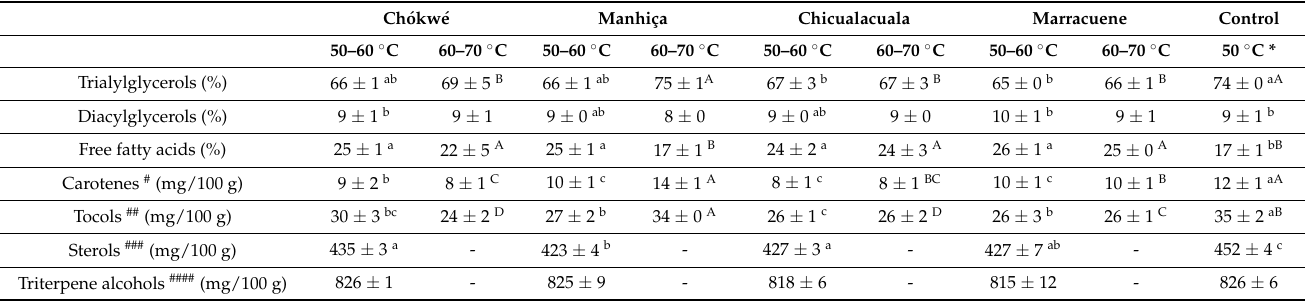
Table 2. Glycerides profile (% TG, DG, FFA), carotenes, tocols, sterols, and triterpene alcohols (mg/100 g) of the oil extracted from the flours obtained at different temperatures from Strychnos madagascariensis fruits (mean ± standard deviation, n = 3 ×